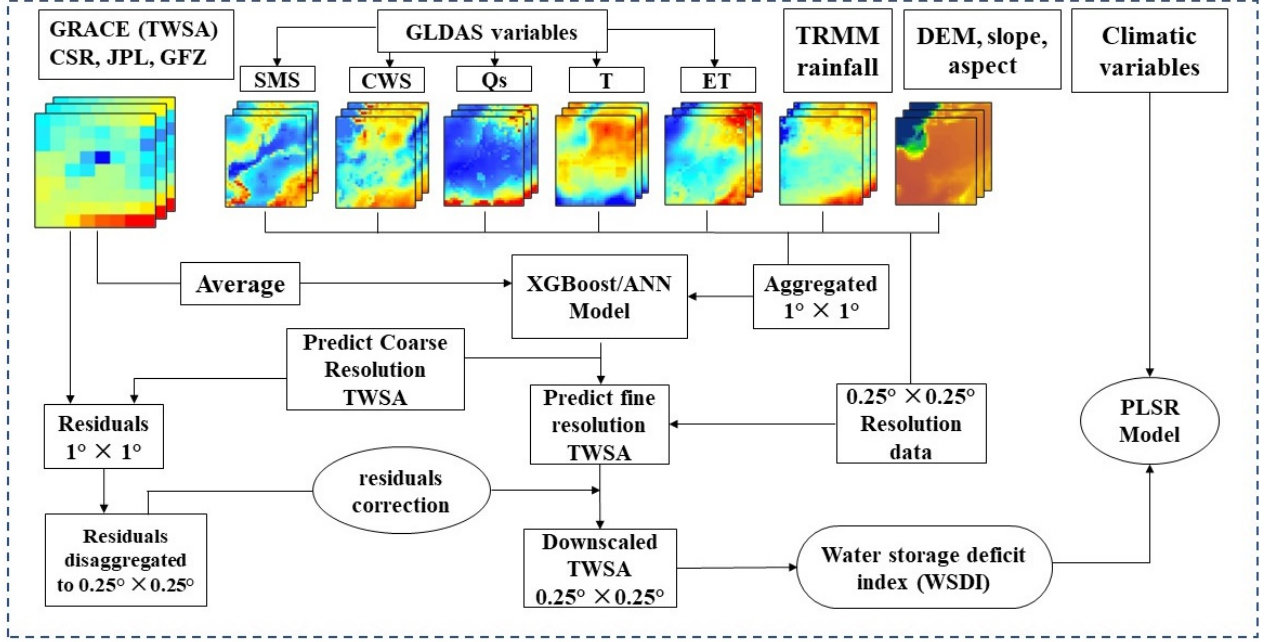
Figure 2. Flow diagram of the downscaling process.